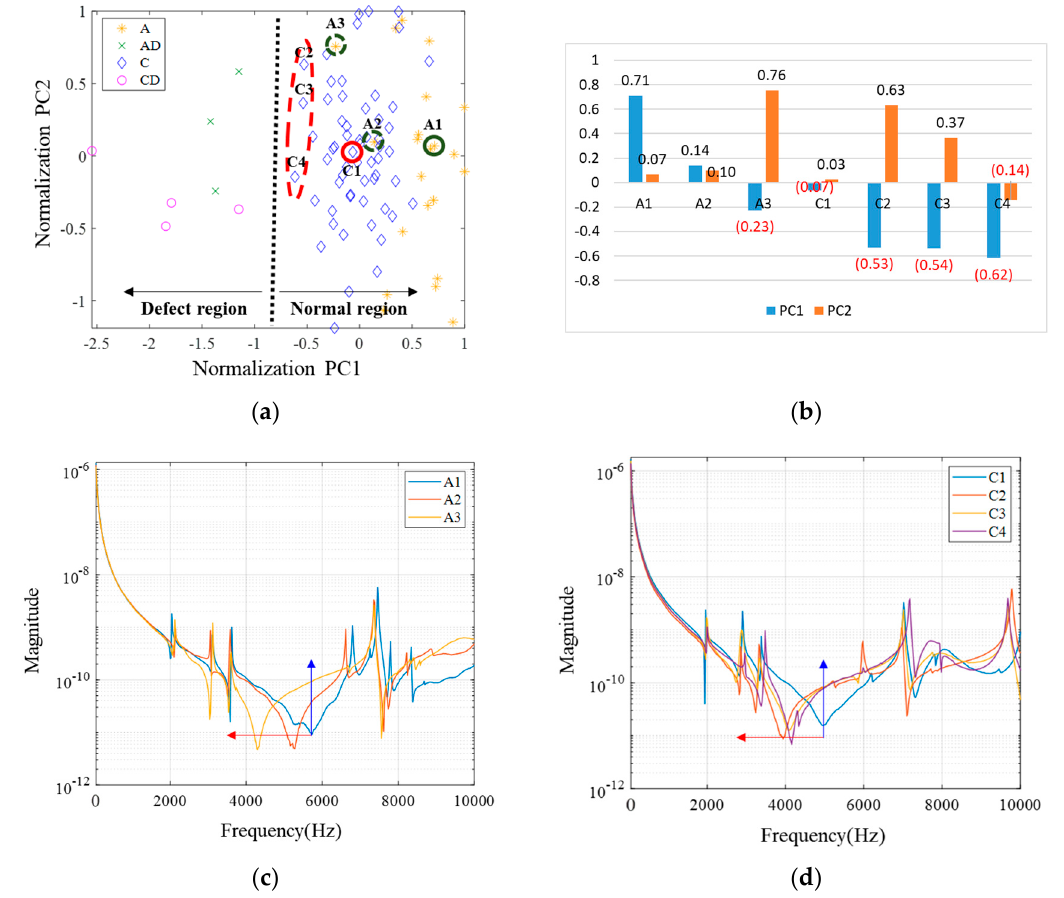
Figure 14. Reanalysis based on the location of the classified data: ( a ) selection of median and boundary and unusual data for each material; ( b ) comparison of PC1 and PC2 values of selected A1–3 and C1–4 data; ( c ) FRF comparison of median and boundary data from normal cristobalite data; ( d ) FRF comparison of median and unusual data from normal alumina data.